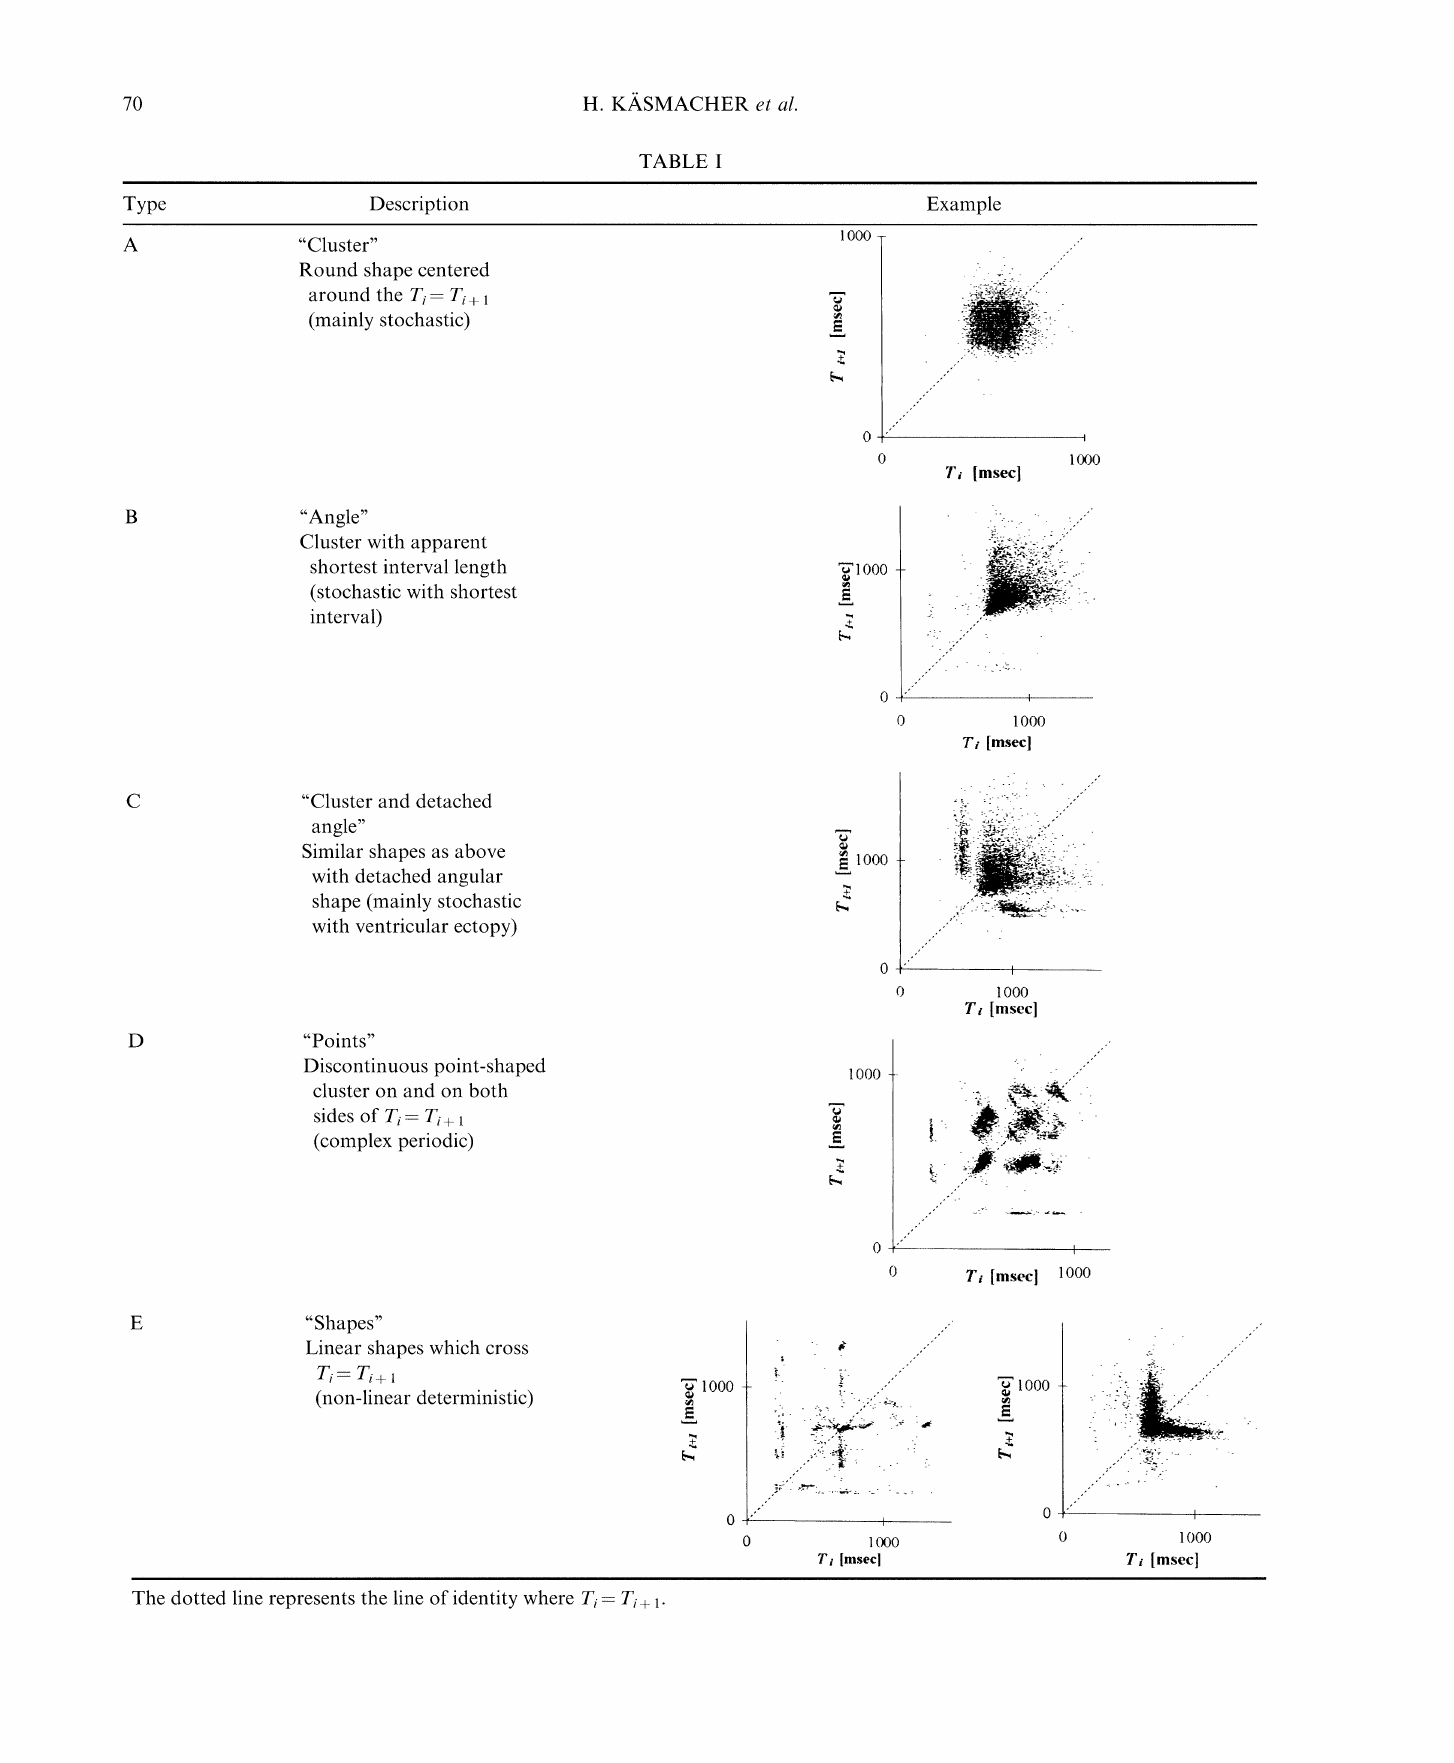
The dotted line represents the line of identity where T; T,- +